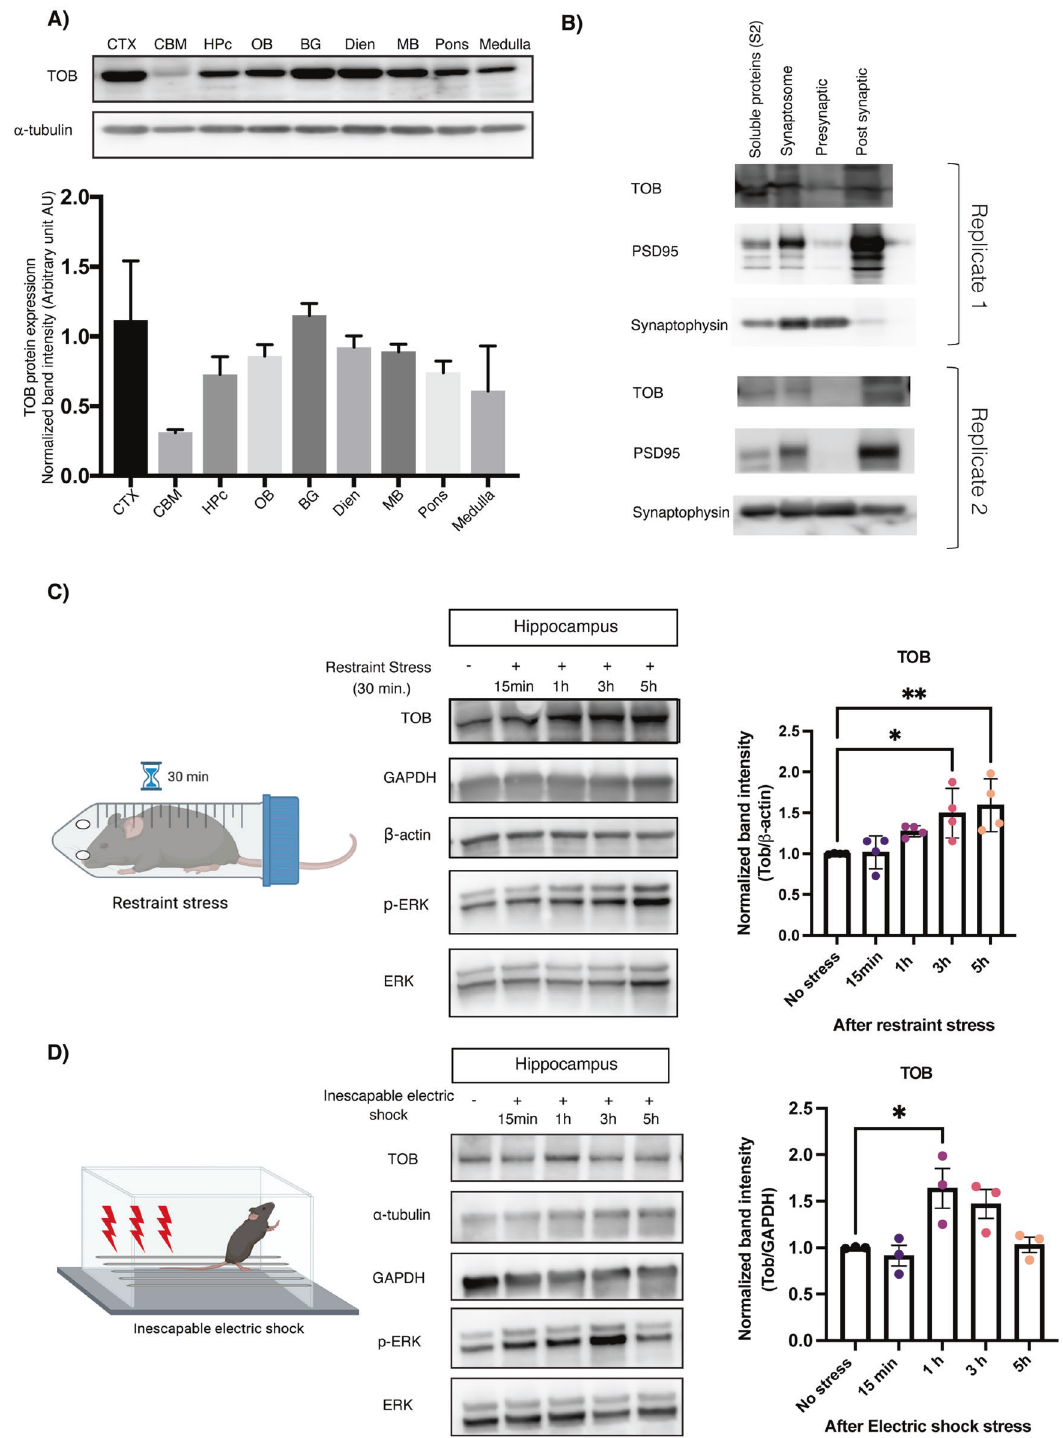
Fig. 1 TOB protein expression levels increase in response to stress. A Expression patterns of TOB in lysates of different mouse brain regions ( n = 3). B Immunoblotting of TOB, synaptophysin, and PSD-95 in hippocampal fractionated lysates: soluble fraction S2, synaptoneurosomes, pre-synaptic, and post-synaptic fractions. C Western blotting of TOB expression levels in hippocampal lysates without stress and after 30 min of restraint stress at different times: 15 min, 1 h, 3 h, 5 h after stress exposure ( n = 4). D Western blotting of TOB expression levels in hippocampal lysates without stress and after inescapable electric shock for different durations: 15 min, 1 h, 3 h, 5 h post-exposure to stress ( n = 3). One-way analysis of variance (ANOVA) followed by Dunnett ’ s post-hoc correction for multiple comparisons: statistical signi fi cance * p < 0.05 ** p < 0.01 when compared to control (No stress). Data are presented as means ±